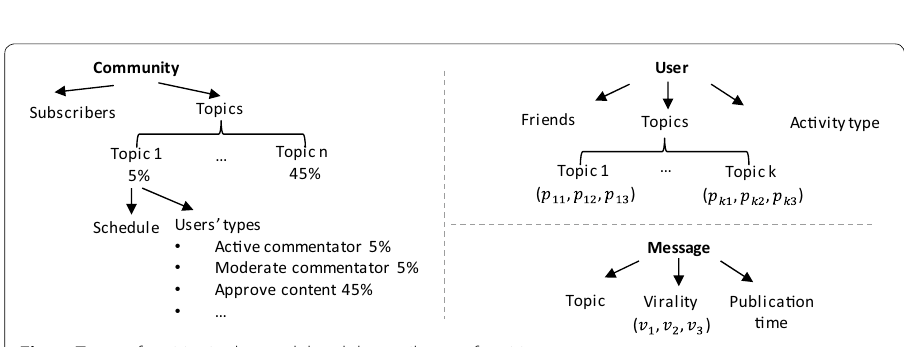
Fig. 4 Types of entities in the model and the attributes of